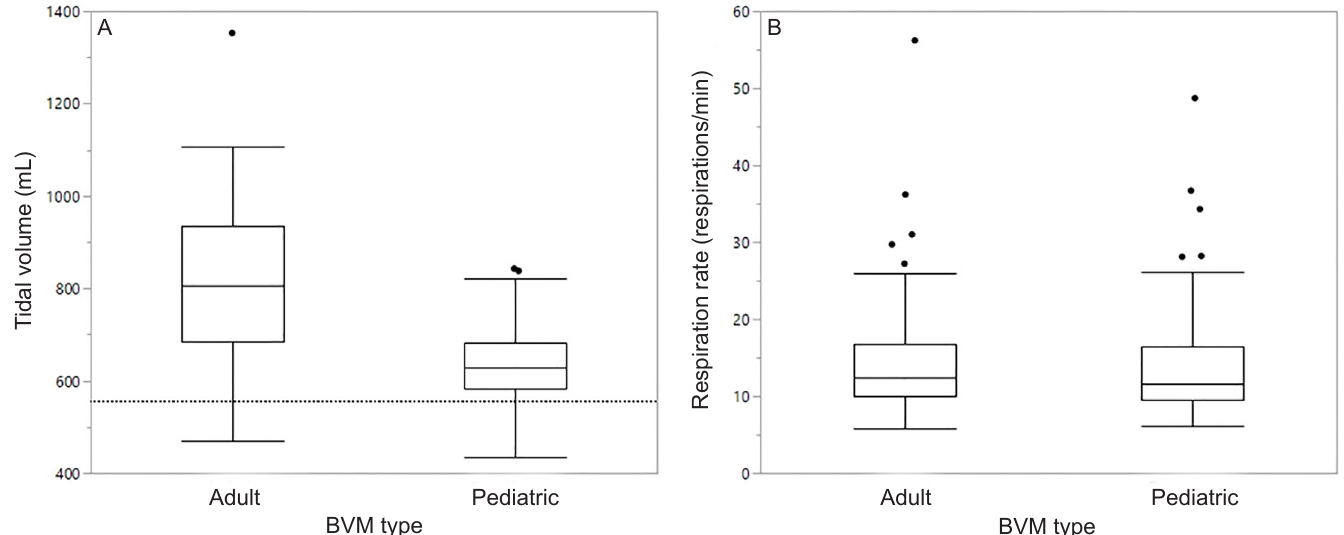
BVM type BVM Figure 1. Side-by-side boxplots of adult vs. pediatric for mean tidal volume (A) and mean respiration rate (B). The dashed line in A represents the idealized upper threshold for an adult male with an ideal body weight of 70 kilograms (kg) at 8 milliliters (mL)/kg, or 560 mL. BVM , bag valve mask; min , minutes.